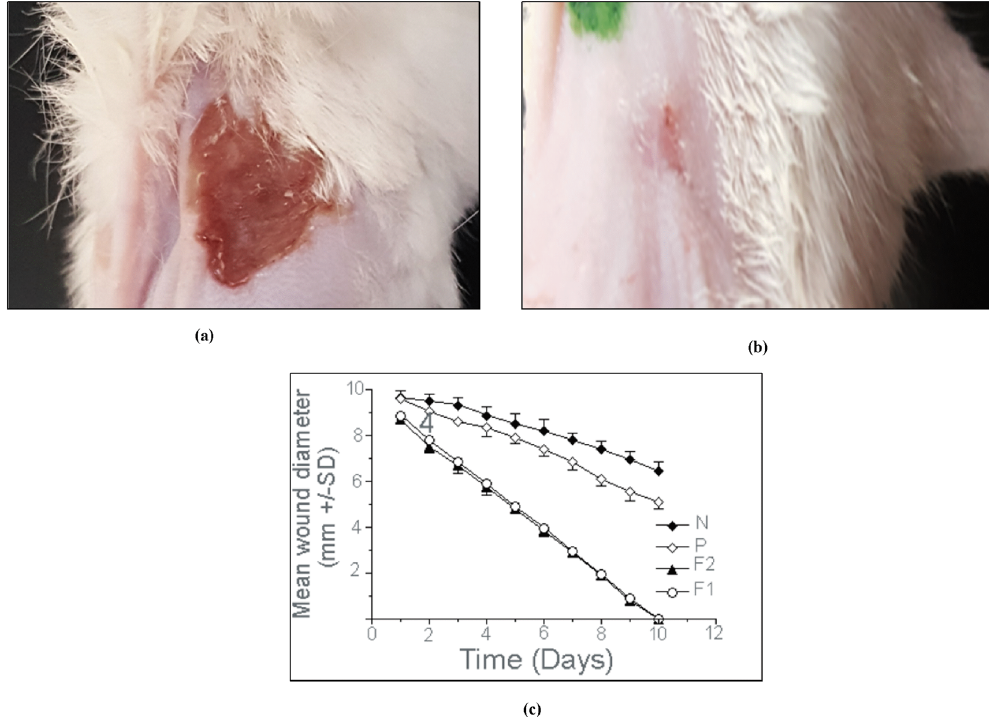
Figure 6. Burn wound position on mouse dorsal skin treated with F1 formula, mouse before application; day 1 ( a ), mouse after end of treatment; day 9 ( b ), mean wound diameter (mm ± SD) daily application ( c ) of F1 (AuNPs-PF127), F2 (AuNPs-PF127-HPMC) and P (silver sulphadiazine cream) compared with N (normal saline).